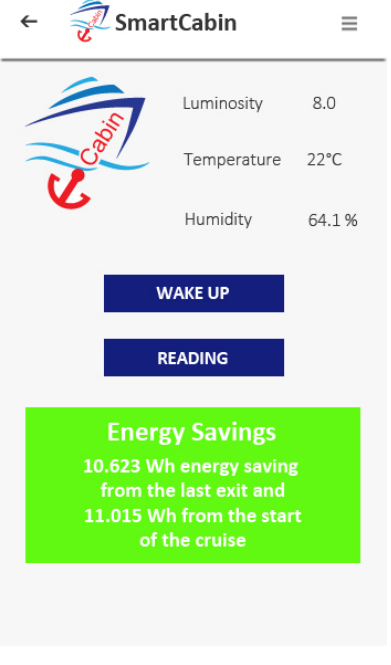
Figure 7. Energy savings